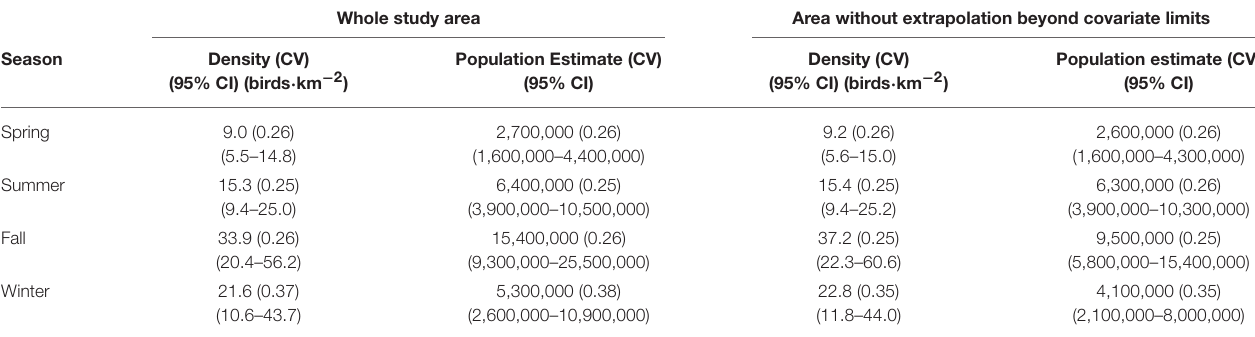
TABLE 2 | Seasonal densities and population estimates (to the nearest 100,000) excluding ice-covered areas for the entire study area and for the area without extrapolation beyond range of model covariates (see Figure 2). Whole study